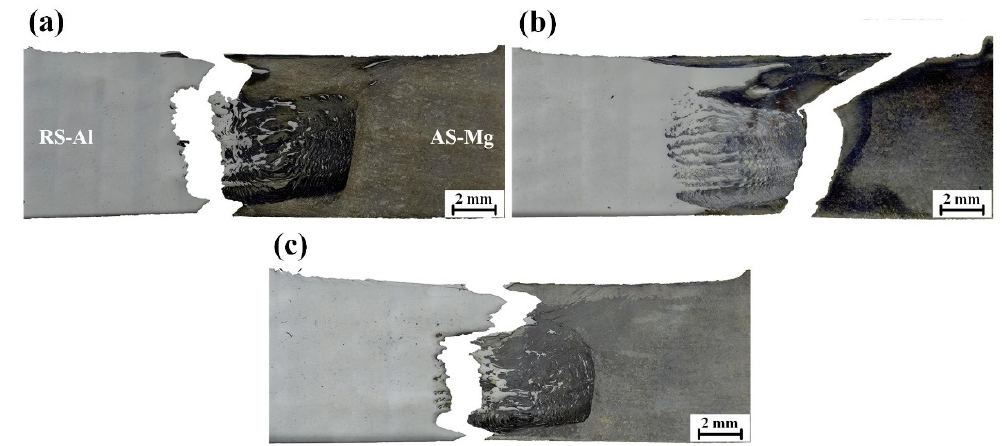
Figure 14. Fracture positions of SFSW at ( a ) 800 rpm, ( b ) 900 rpm, and ( c ) 1000 rpm.